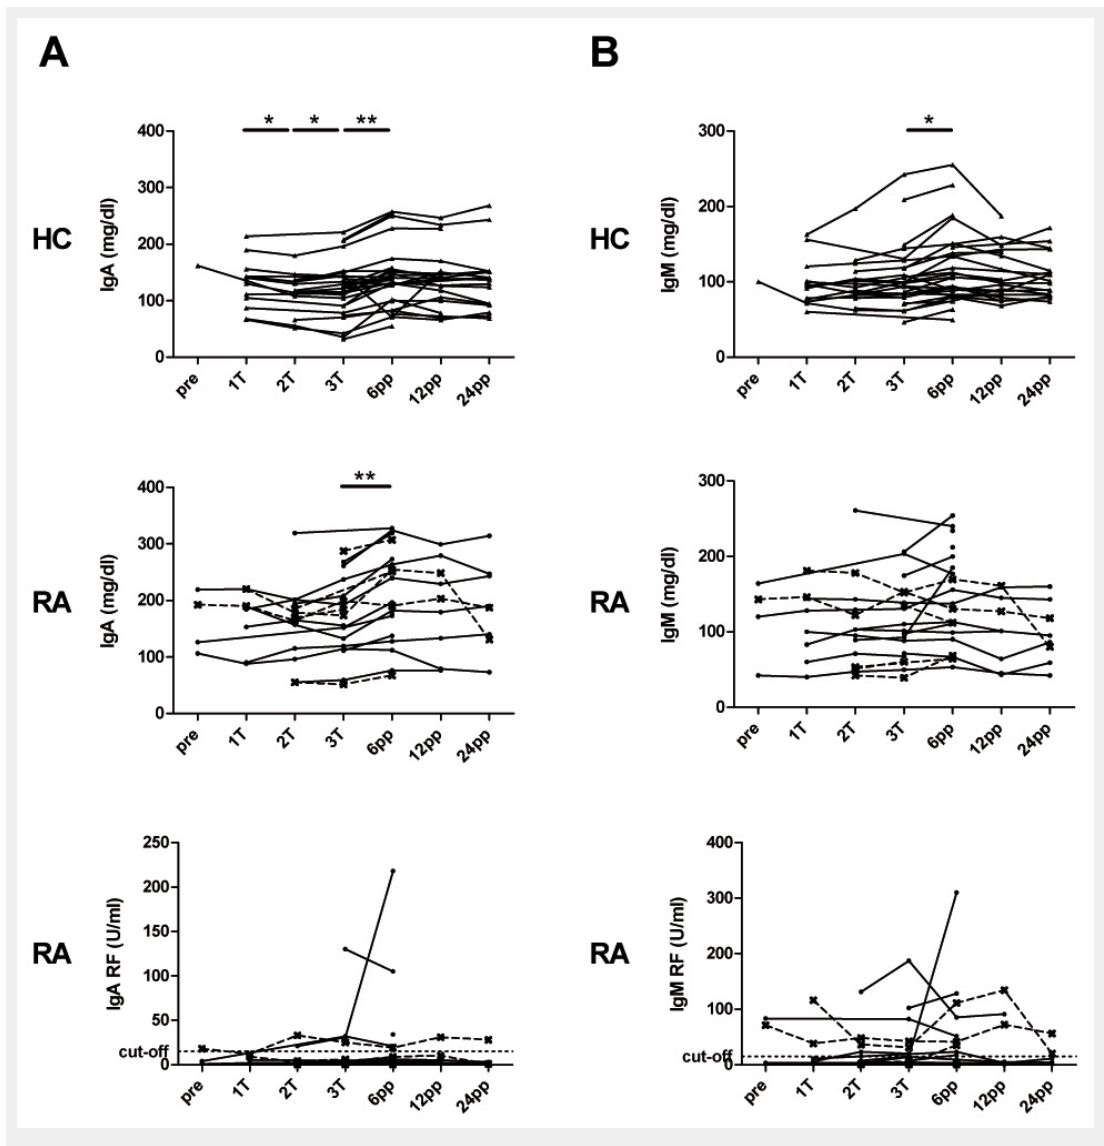
Supplementary Figure Levels of IgA and IgM as well as IgA-RF and IgM-RF during and after pregnancy. Sera of healthy controls (HC, n = 29) and RA patients (n = 22) were analysed before conception (pre), at the 1 st (1T), 2 nd (2T) and 3 rd (3T) trimester as well as 6, 12 and 24 weeks post partum (wpp) for IgA (A) and IgM (B). In RA patients, longitudinal changes of the immunoglobulin levels were compared with those of the IgA-RF (A) and the IgM-RF (B). No significant difference was found between RA patients with persistent active disease (dashed lines) and those with low disease activity during pregnancy (black lines). * P <0.05, ** P